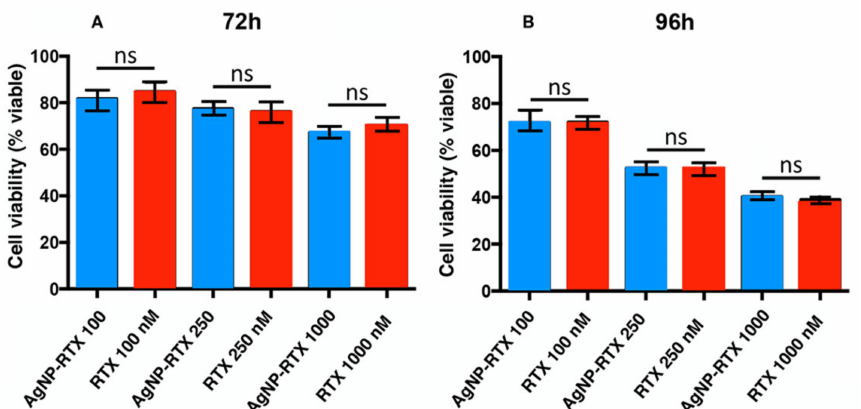
Figure 4. Behavior of the A549 cells after treatment with AgNP-Cys-RTX (blue bar) and RTX (red bar) at different time periods ( A ) 72 h ( B ) 96 h and concentrations. The NP concentrations are expressed as nM of RTX. Each bar represents the mean +/ − SEM of three independent experiments performed in triplicate normalized to non-treated cells (taken as 100%). Differences were analyzed performing an ANOVA followed by a Newman–Keuls multiple comparison test. ns—no